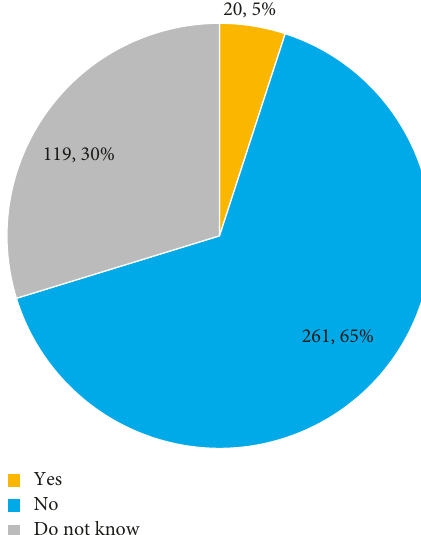
Figure 1: Awareness regarding gum disease as a risk factor for preterm